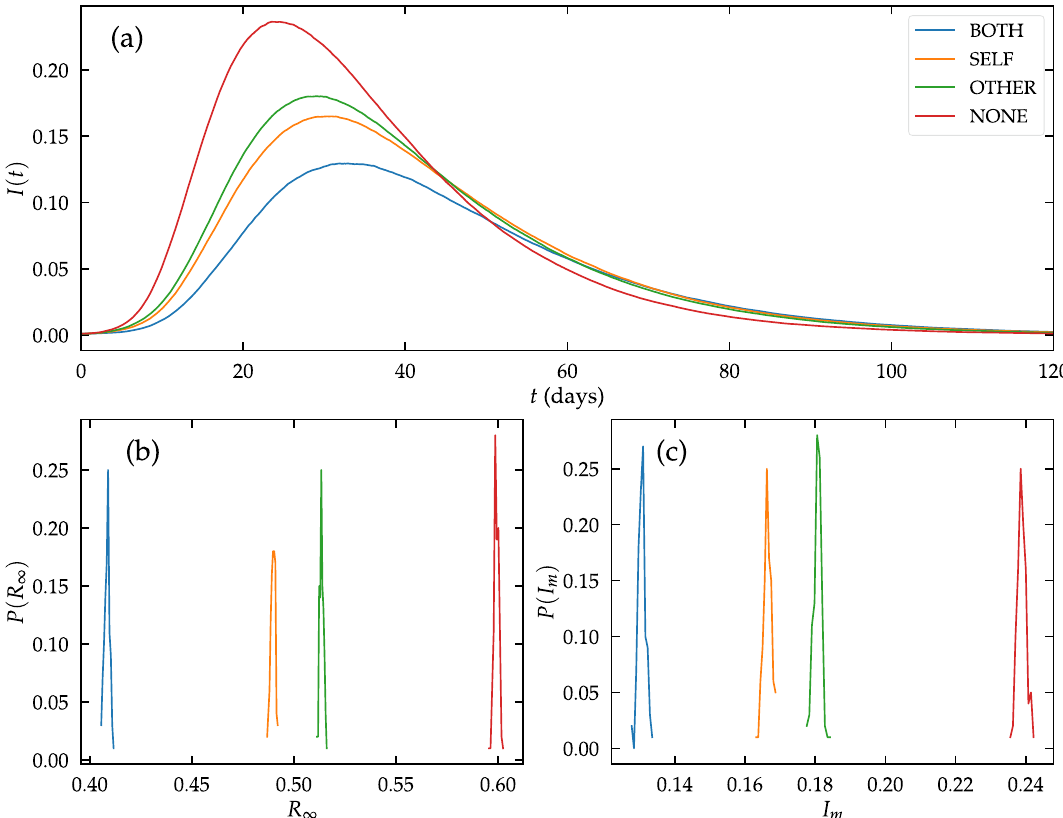
Figure 4. SEIR dynamics on the Portland network. ( a ) I vs t for a single run; ( b ) Distribution of the fraction R of recovered people in the asymptotic state for 100 runs in each of the 4 scenarios; ( c ) Distribution of the maximum fraction I m of simultaneously infected people for 100 runs in each of the 4